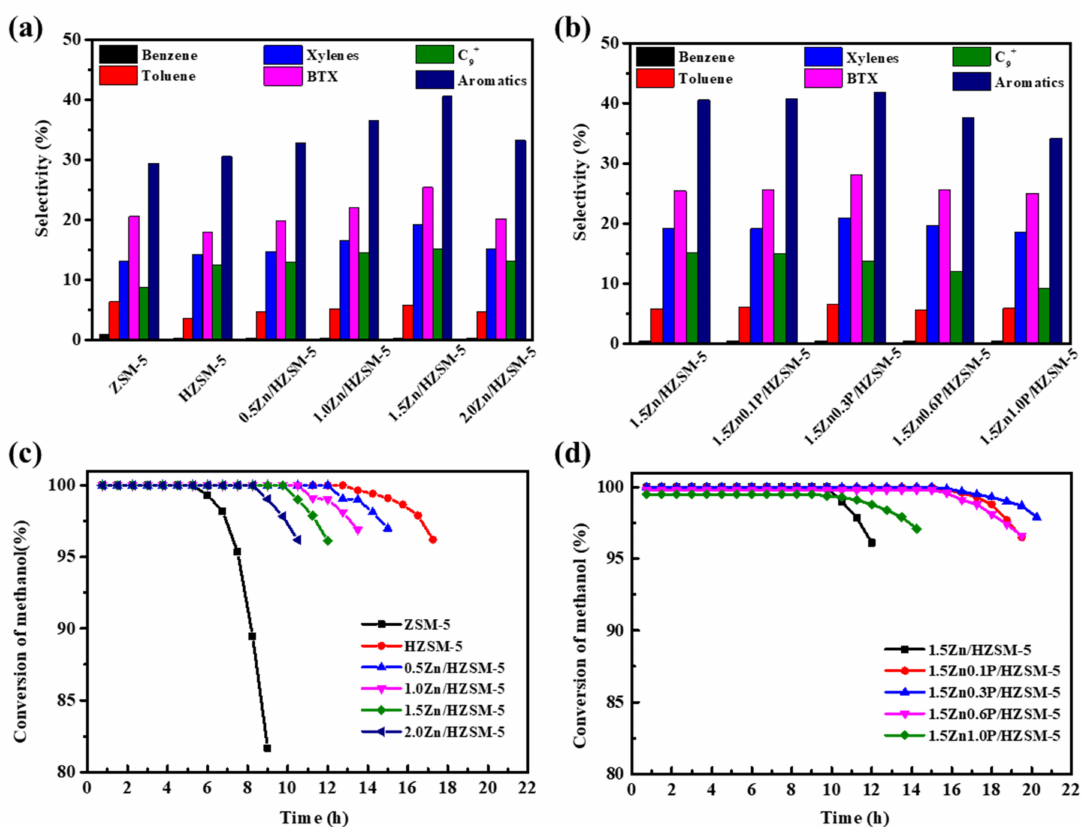
Figure 7. Aromatic product distribution ( a , b ) and conversion of methanol versus time ( c , d ) over ZSM-5, HZSM-5, Zn modified and Zn-P co-modified